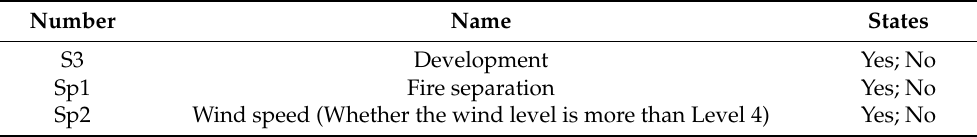
Table A7. The name and states of the nodes related to spread in Bayesian network.